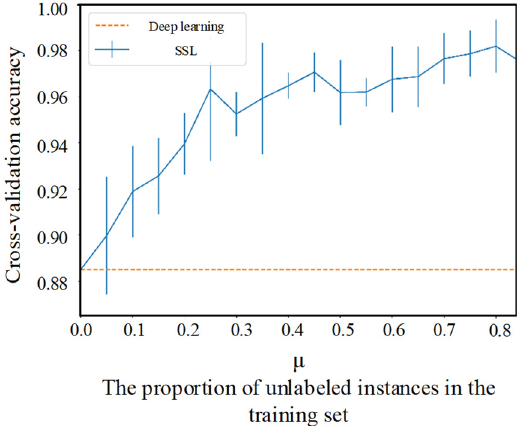
Figure 12. Comparison of SSL and deep learning method trained by the same amount of labeled data. The µ is the proportion of unlabeled instances in the training set defined in the Equation (5).